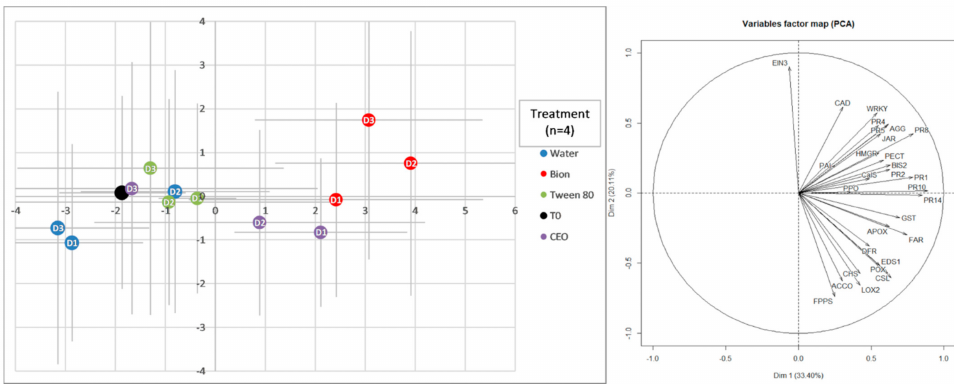
Figure 4. Effect of C. cassia EO (CEO 1% ( v / v )), Bion, tween 80 and water application on mean normalised log 2 expression level ( n = 4) by days of 29 mRNA transcripts of selected defence genes analysed by principal component analysis (PCA) with barycenter representation ( left ) and variable contribution to dimensions ( right